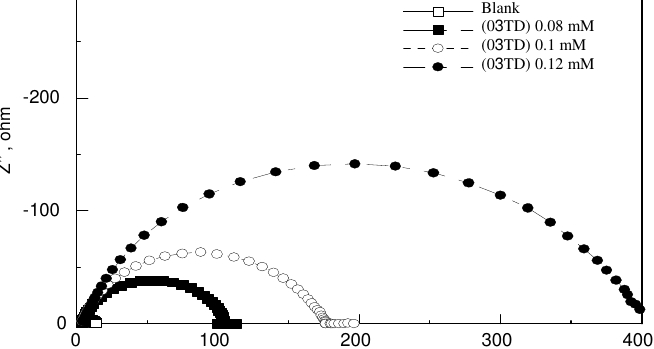
SO in the absence and presence of (02TD). 2 4